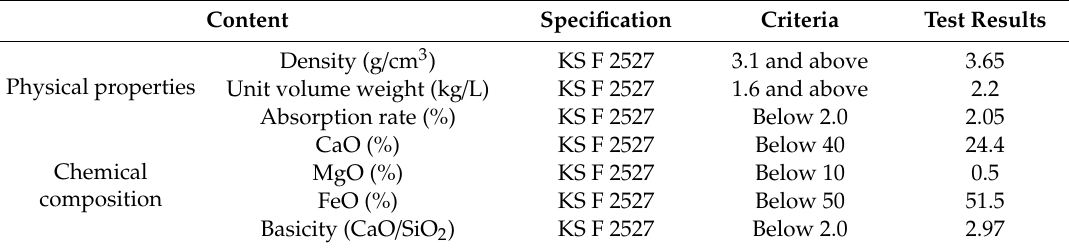
Table 5. Physical properties and chemical composition of steel